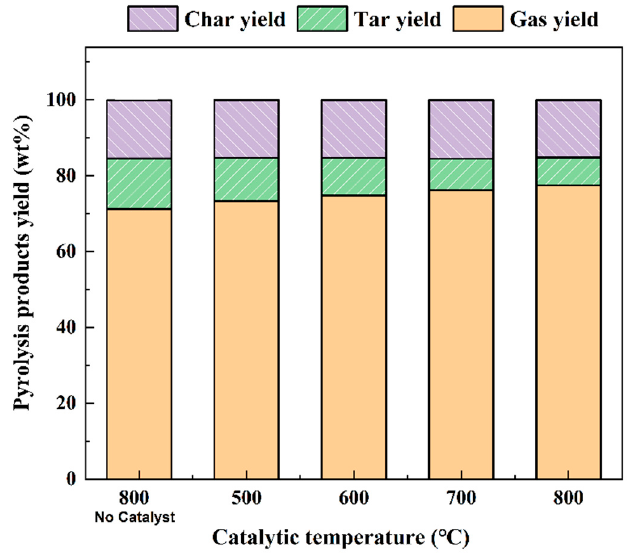
Figure 4. Effect of catalytic temperature on the distribution of pyrolysis products of pine sawdust.